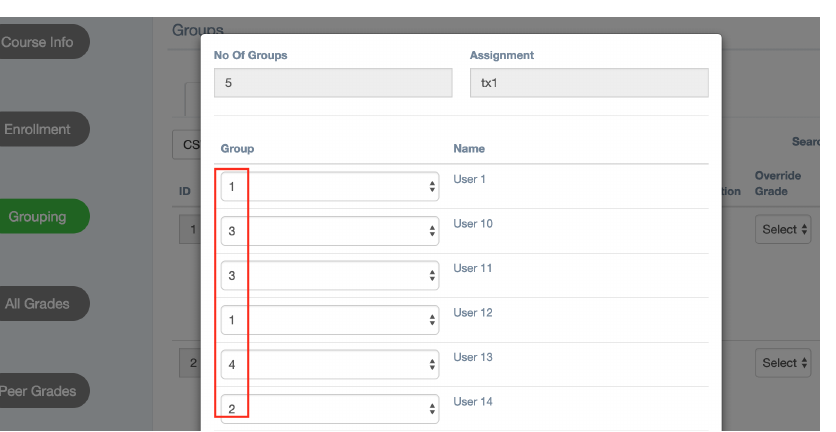
Figure 5. Semi-automated grouping. Note that the values in the group column are system defaults from random grouping. Repeated values indicate students share a group. Instructors can manually switch students by changing their group